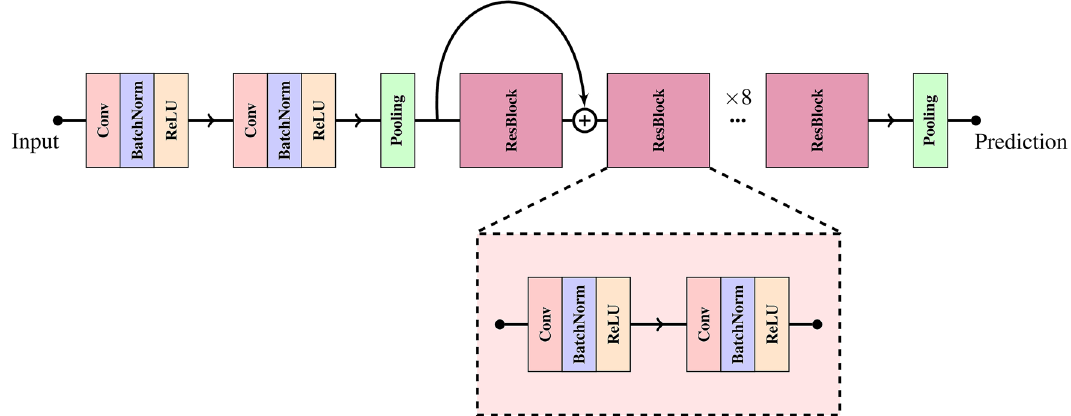
Figure 2. The convolutional neural network-based architecture used for all experiments. Each red block corresponds to a convolutional layer, the blue blocks represent a batch normalization layer, the yellow blocks are ReLU activations, and the green block represents average pooling. Besides these base building blocks, the model consists of eight residual modules (purple blocks) composed of two sequential blocks of convolution, batch normalization, and ReLU